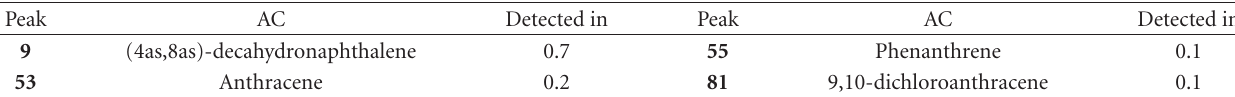
Table 10: ACs detected in the products from ASF ODVR .